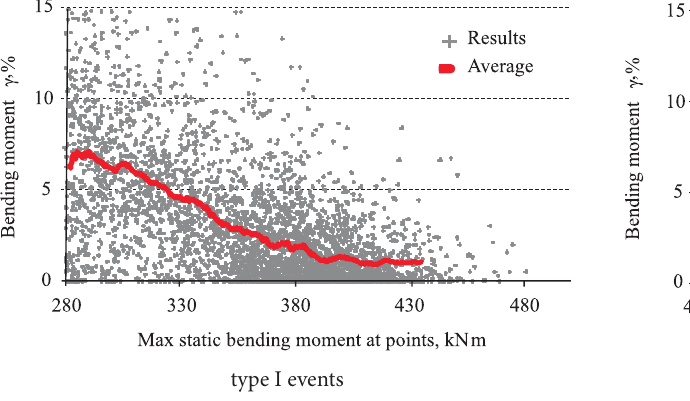
Fig. 11 compares the mean DAF values obtained for single and meeting vehicle events on a 7.5 m bridge with class B road roughness and two boundary conditions.